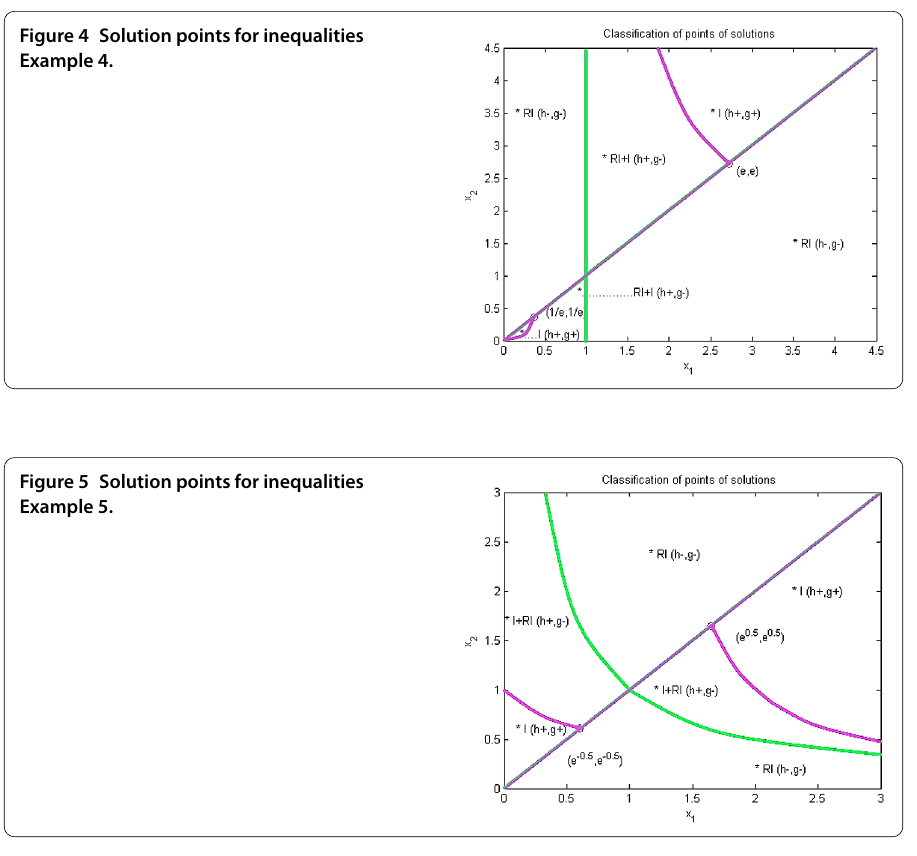
Figure 4 Solution points for inequalities Example 4.